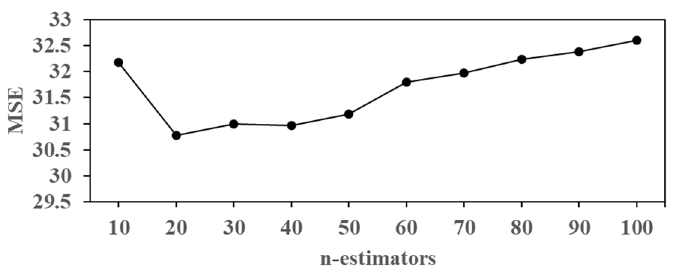
Figure 13. The MSE of gradient boosting regression tree model(GBRT-M) with different n-estimators . Note: the range of n-estimators is from 10 to 100, and the step length is 10.